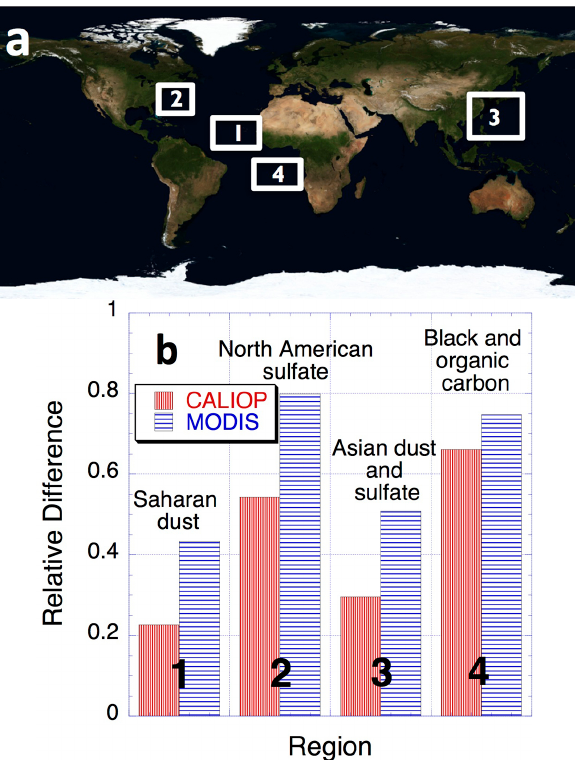
Fig. 3. Regional differences in near-cloud enhancements. (a) Ge- ographical location of four regions dominated by different aerosol types. The coordinates of the four regions are as follows: 1: (5– 20 ◦ N, 15–45 ◦ W), 2: (25–45 ◦ N, 55–80 ◦ W), 3: (15–45 ◦ N, 110– 140 ◦ E), 4: (0–20 ◦ S, 20 ◦ W–10 ◦ E). (b) Near-cloud relative en- hancements of particle scattering in the four regions, as observed by CALIOP and MODIS. These relative enhancements (RE) are ob- tained using RE = ( X d < 5km − X d > 5km ) / X d > 5km , where X is the particle contribution to either 532nm CALIOP backscatter ( β p ) or 0.55µm MODIS reflectance ( R p ) , and d is distance to the nearest cloud below the altitude of the 700hPa pressure level ( ∼